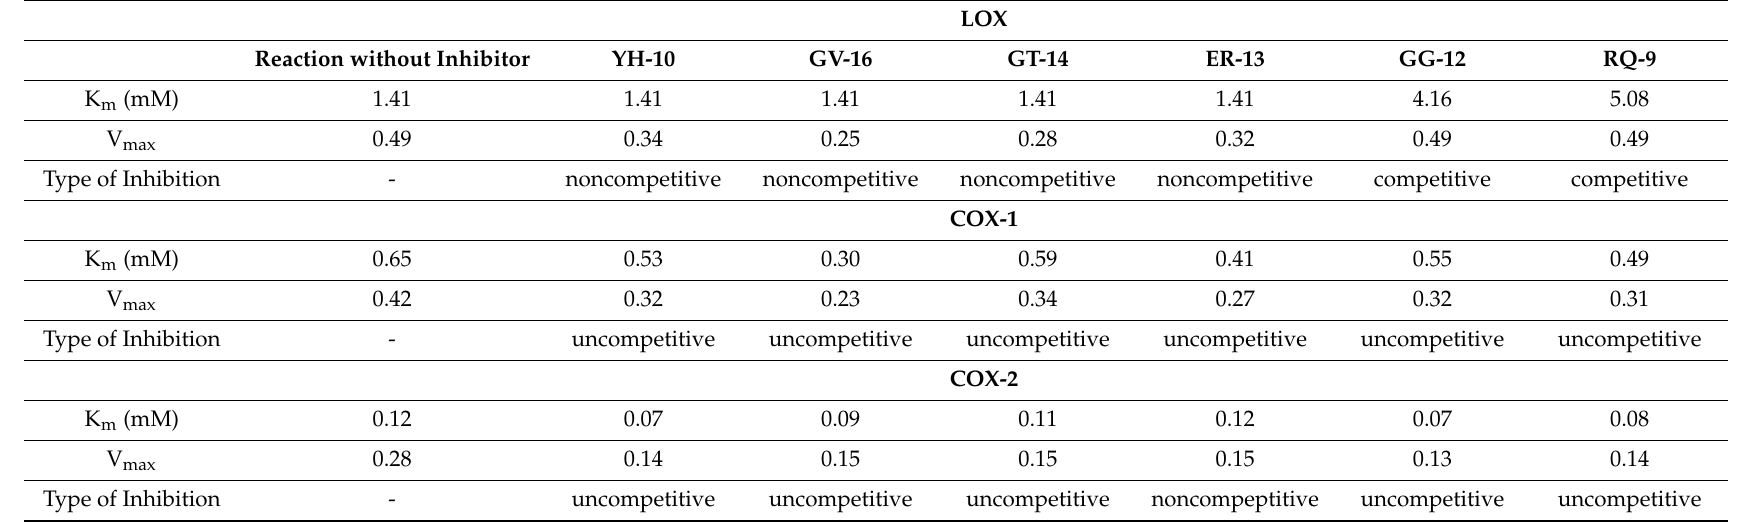
Table 5. Kinetic parameters of enzymes involved in inflammatory process pathogenesis with peptides as inhibitor and type of inhibition.